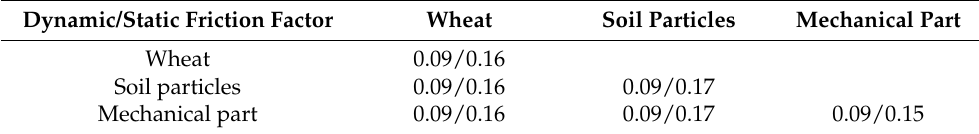
Table 2. Dynamic/static friction factors among various types of particles.